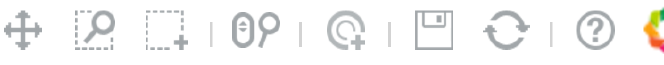
Figure 5. Bokeh Toolbar (the last two buttons at the rightmost end of the toolbar are just links for more information about Bokeh and they don’t serve any interaction